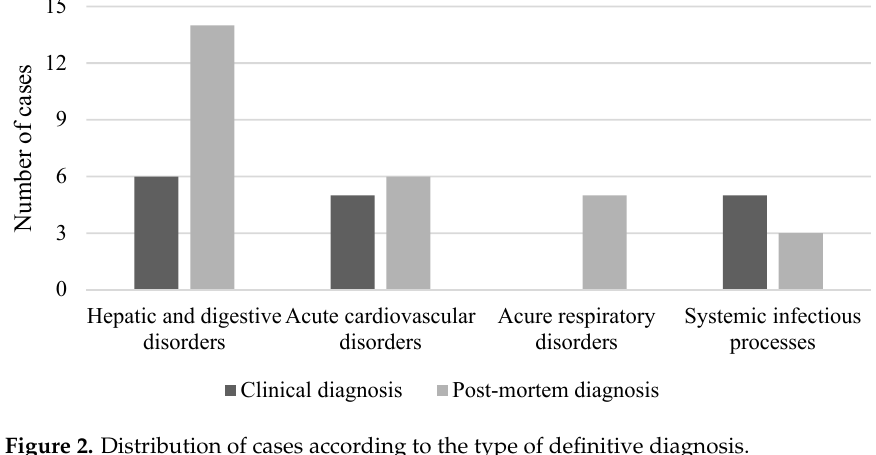
Figure 2. Distribution of cases according to the type of definitive diagnosis.